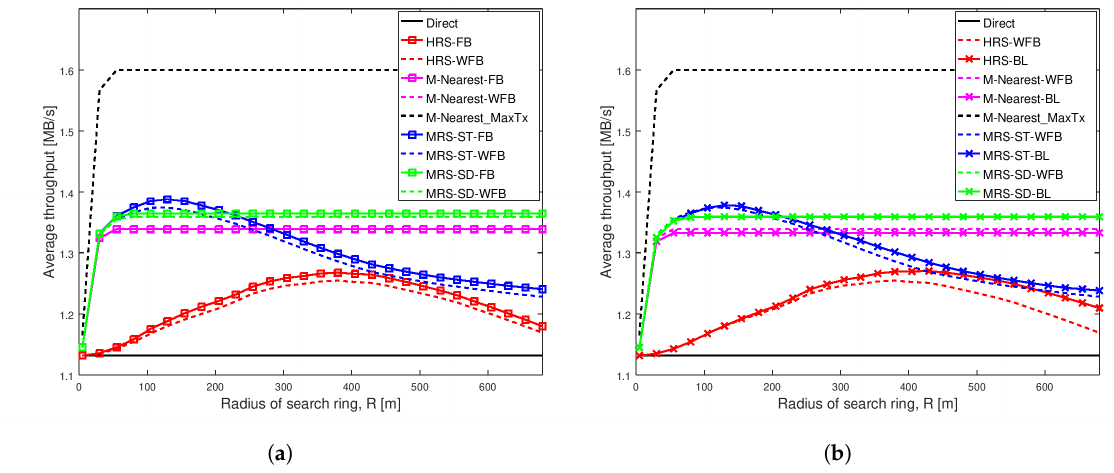
Figure A2. Average throughput of different schemes when Shape = 1.01 and Scale = 0.01 in a network having width of 1000 m. ( a ) Different battery power levels not considered in relay election; ( b ) Different battery power levels considered in relay